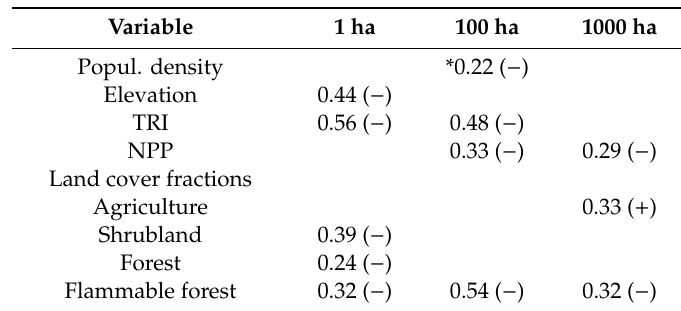
Table 5. Univariate explanation ( r 2 ) of regional variability in daily FWI thresholds for fires attaining 1, 100, and 1000 ha through regional descriptors and relationships of the form log(y) = a + b log(x). Missing values indicate non-significant ( p > 0.05) e ff ects. Negative and positive influences are represented respectively by ( − ) and ( +